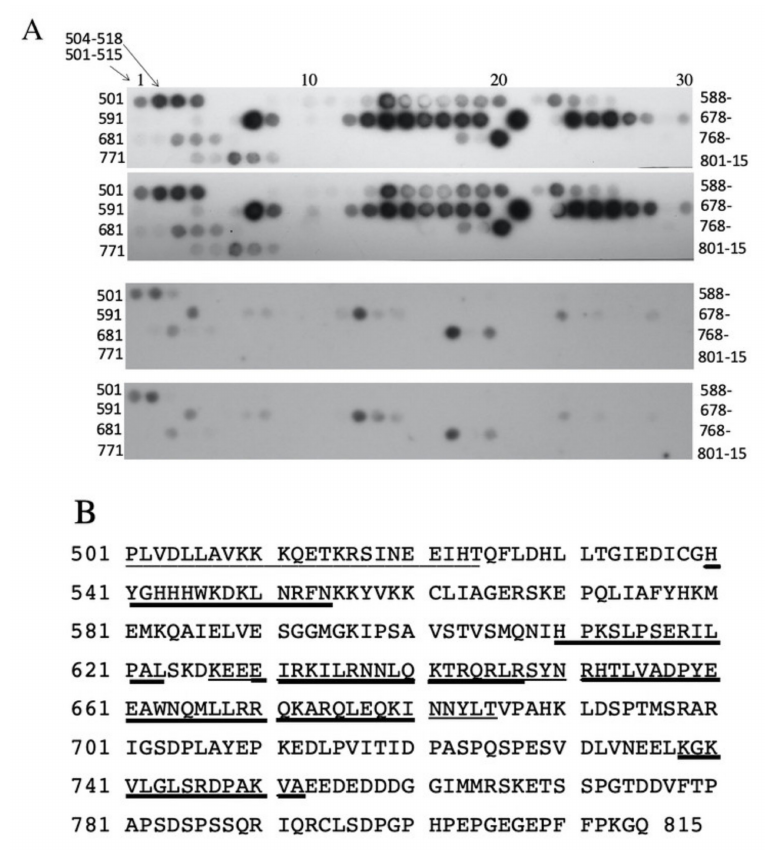
Figure 7. Synthetic peptide array blot [15] of amino acids 501–815 of the human NHE1 C-terminus region that was probed with HA-tagged peptide-containing amino acids ( 562 LIAGERS 568 ). The N-terminal peptide of the peptide array is indicated. Each spot on the array contained a peptide of 15 amino acids in length. The adjacent peptide was shifted by three amino acids, as indicated. ( A ) Illustration of results of probing (in duplicate). The top two panels were probed with the peptide of the N-GL IAGE RSYPYDVPDYAG sequence. The bottom two panels were probed with the peptide N-GLAAAARSYPYDVPDYAG sequence. ( B ) NHE1 C-terminal amino acids indicating regions of stronger binding to the tagged peptide. Underlined sequences indicate the amino acids of the 15mer peptide(s) that bound to the probe, and the thicker line indicates a higher level of binding. Results are typical of four experiments.